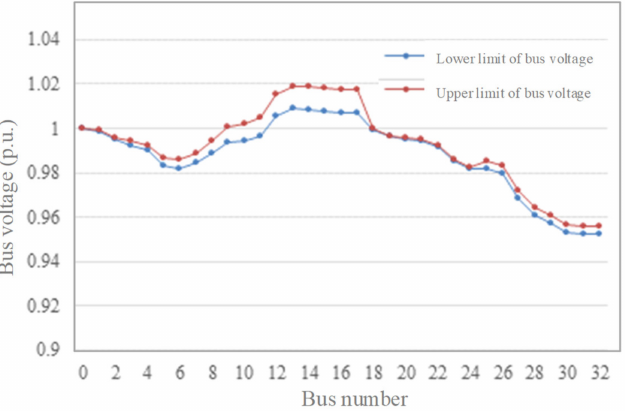
Figure 5. Bus voltages in power system with uncertainty considered under high load.